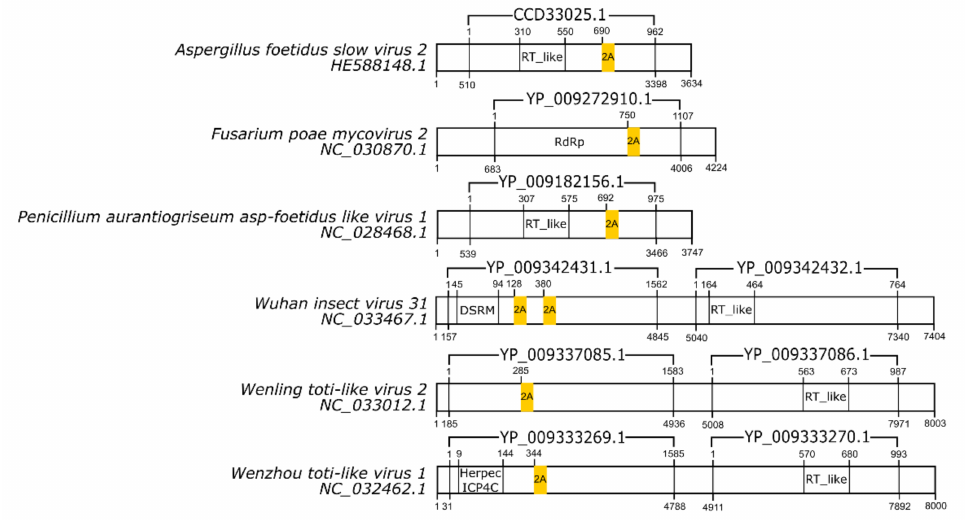
Figure 2. Schematic representation of double-stranded RNA virus sequences. Schematic representa- tions of dsRNA virus sequences showing the location of each respective 2A-like (yellow rectangles). The nucleotide positions and size of each predicted polypeptide are represented by the numbers below and above the bars, respectively. The annotations of each viral sequence were made according to the information available at the NCBI. The nucleotide and protein accession numbers are located forward and above each scheme, respectively. Representations of each genome are not in